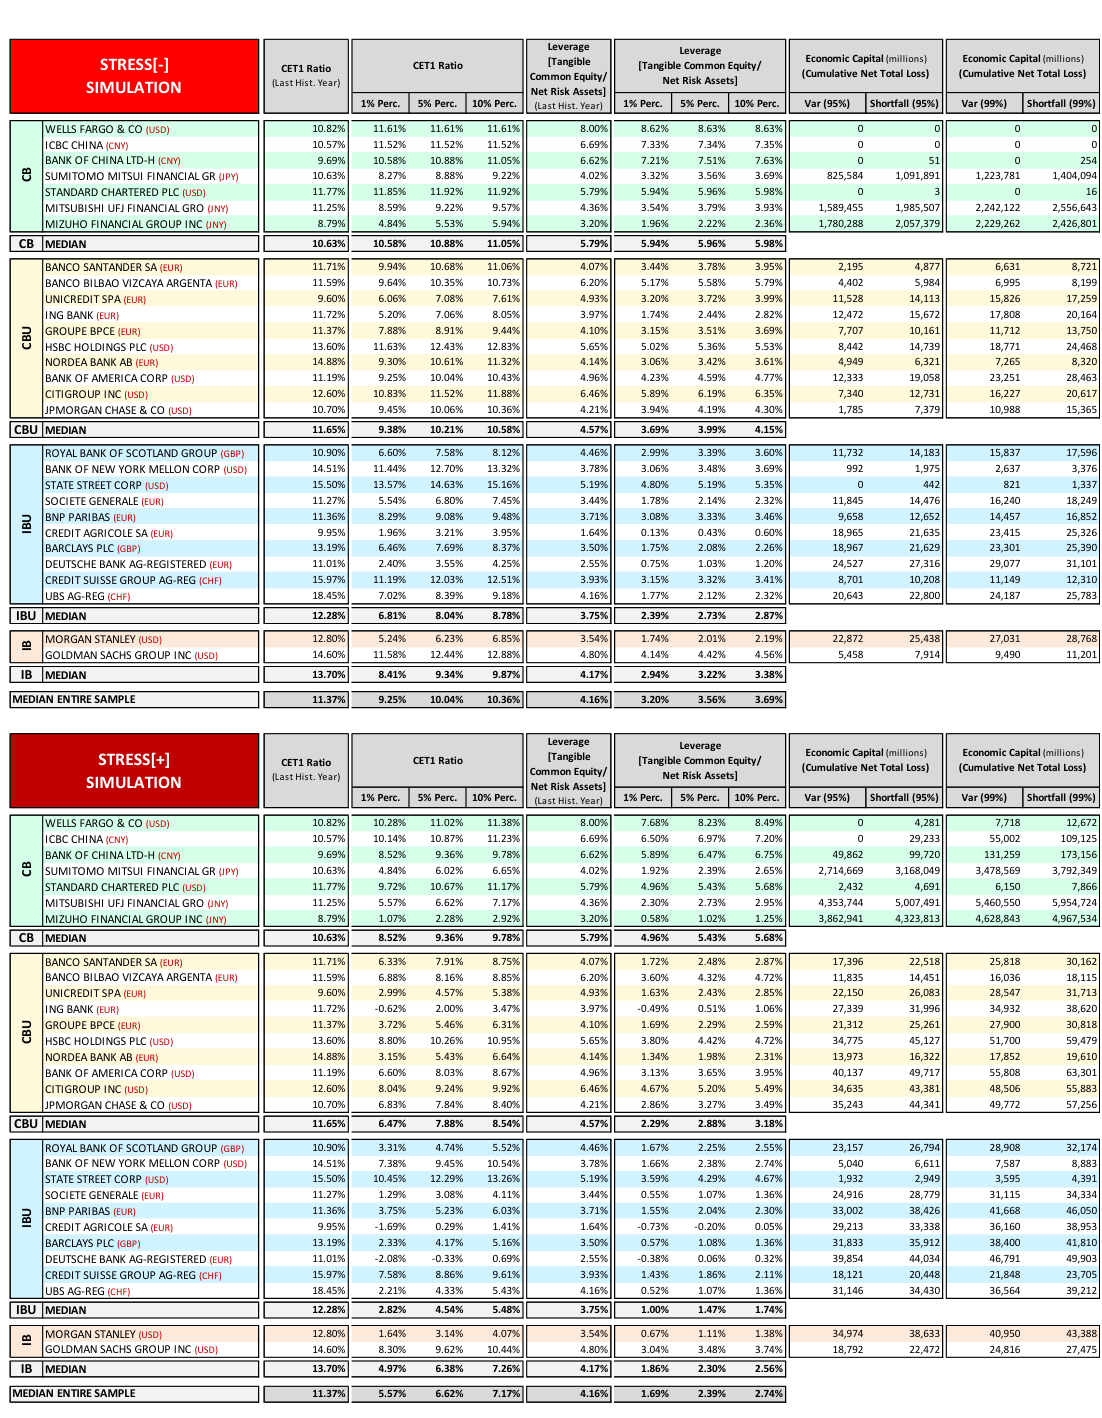
Figure A7. 2015 Stress test exercise: capital adequacy and economic capital.